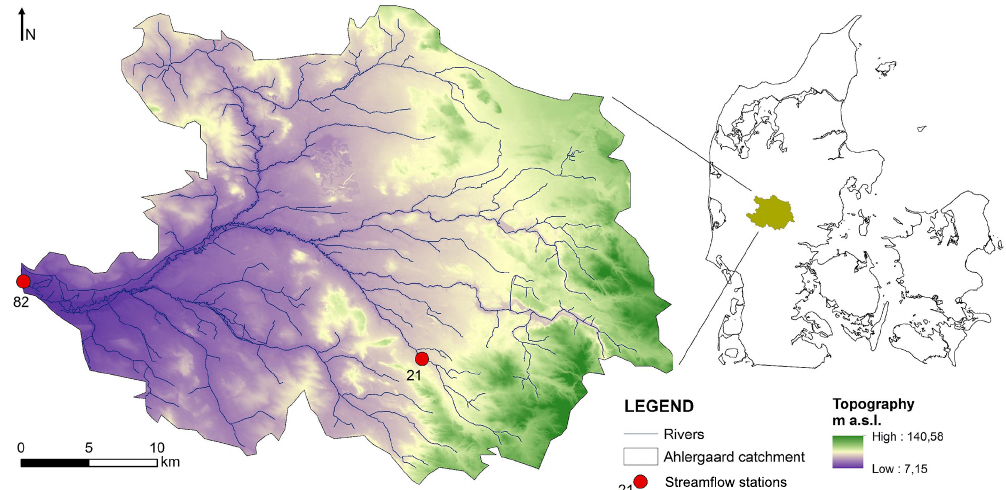
Figure 2. Location and topography of the Ahlergaarde catchment. The outlet station (82) and the upstream sub-catchment (21) are used in the study.